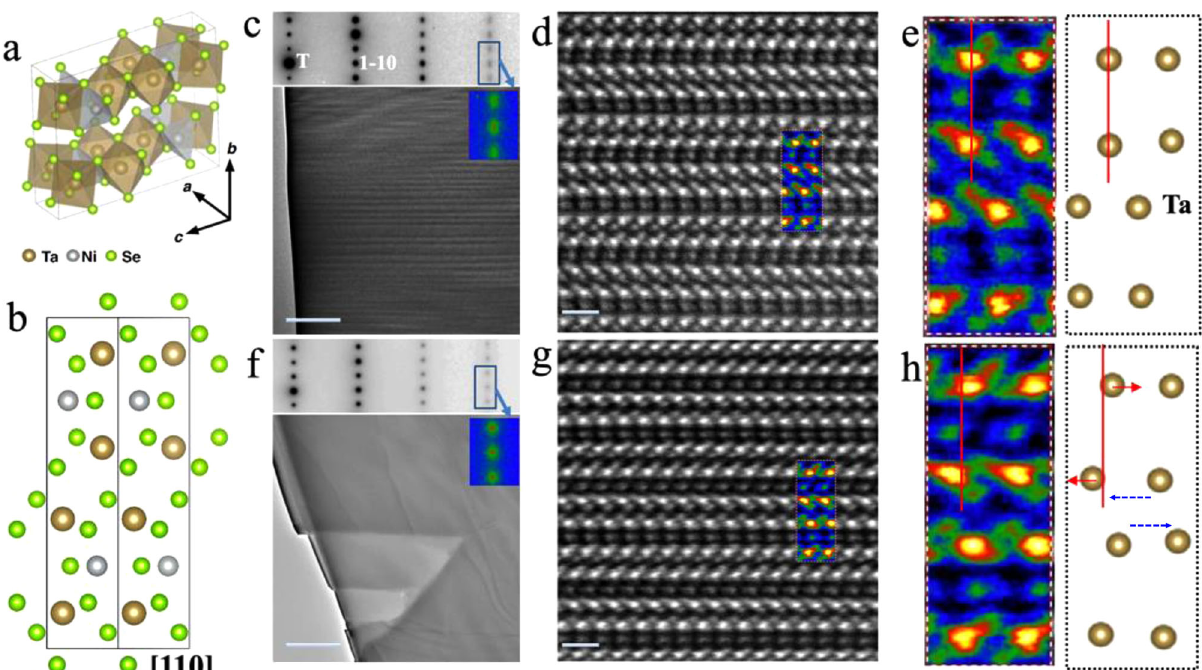
Fig. 3 TEM structural characterization of both pristine and laser-treated Ta 2 NiSe 5 . a Perspective view of Ta 2 NiSe 5 atomic model. b Projection view along [110] zone-axis. c For pristine Ta 2 NiSe 5 , [110]-oriented electron diffraction pattern and morphology, inset shows the zoom-in part of the splitting of (3-30) re fl ections due to the twinning formation. d Atomically-resolved high-angle annual dark- fi eld image taken along [110] zone-axis corresponding to ( c ). e Enlarged part outline in ( d ), with a schematic of Ta atom columns corresponding to the brightest contrast. Descriptions for ( f , g , h ) are the same as ( c – e ) but for hidden state Ta 2 NiSe 5 . Red line and arrows in ( h ) mark the small relative displacement of Ta atoms with respect to the one in ( e ). The blue dashed arrows denote the locate where large Ta-atoms relative displacement occurred. Scale bars in ( c , f ) correspond to 500 nm, in ( d , g ) correspond to 0.5 nm. False colors scales with the image intensities for the purpose of visual